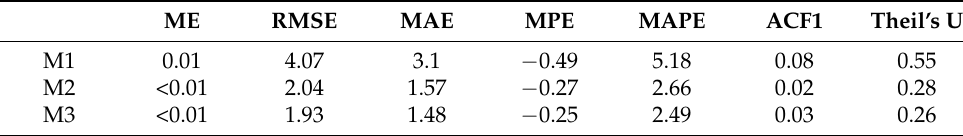
Table 5. Loneliness’s hybrid model accuracy measures.